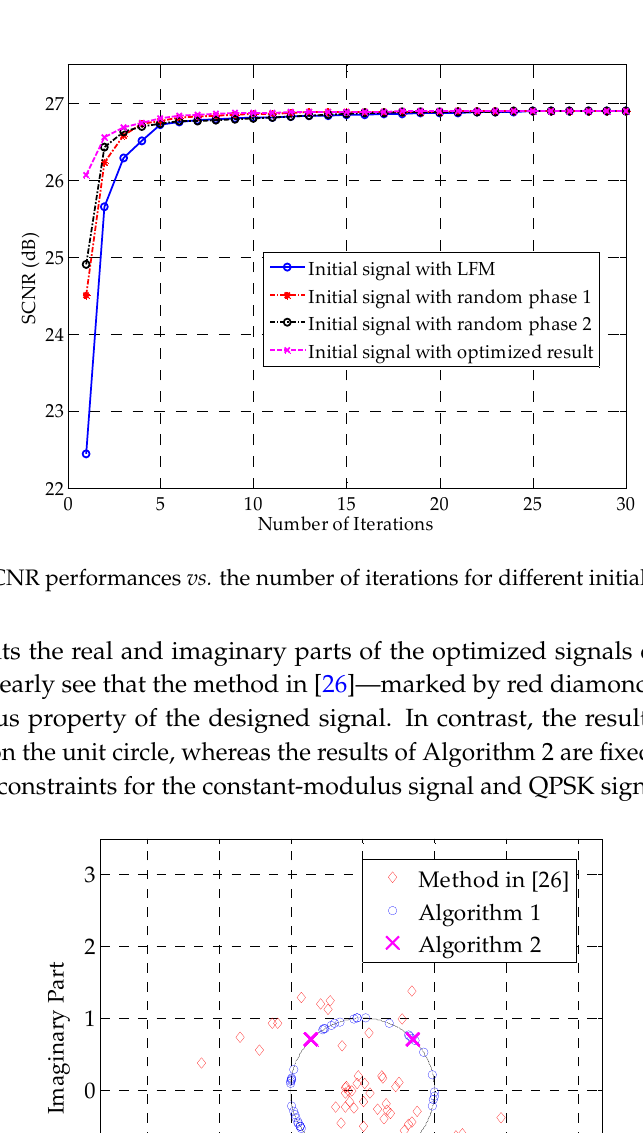
Figure 7. Real and imaginary parts of different methods’ results.